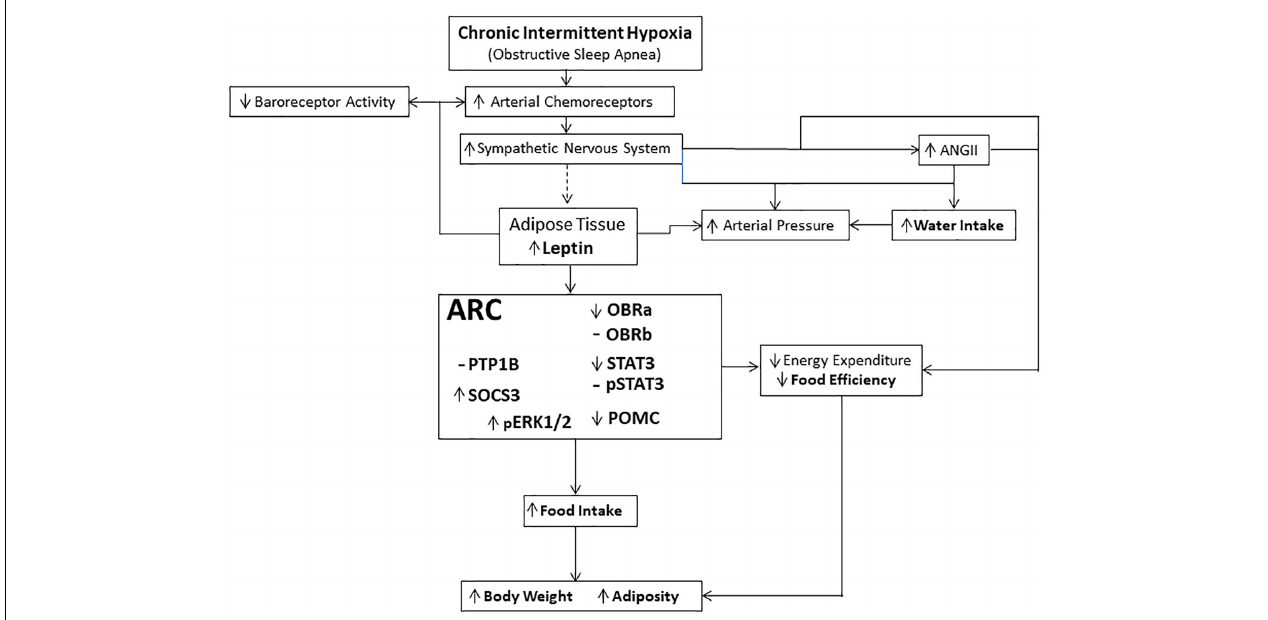
FIGURE 8 | Schematic representation of the physiological pathways involved in mediating the effects of long-term exposure to continuous intermittent hypoxia on leptin and body weight. Dashed line (—) indicates that the link between the activation of the sympathetic nervous system and release of leptin is suggestive based on the evidence of sympathetic innervation of adipocytes and their shrinkage in size during activation, and the data suggesting that plasma leptin concentration is related to adipocyte size (Guerre-Millo, 1997; Jéquier, 2002; Ciriello, 2013; Ciriello and Moreau, 2013). Hypothalamic centers receive and integrate the leptin signal, through activation of leptin receptors, that manifests itself through several effector systems, including the sympathetic nervous system controlling energy expenditure (Guerre-Millo, 1997; Haynes, 2000; Jéquier,